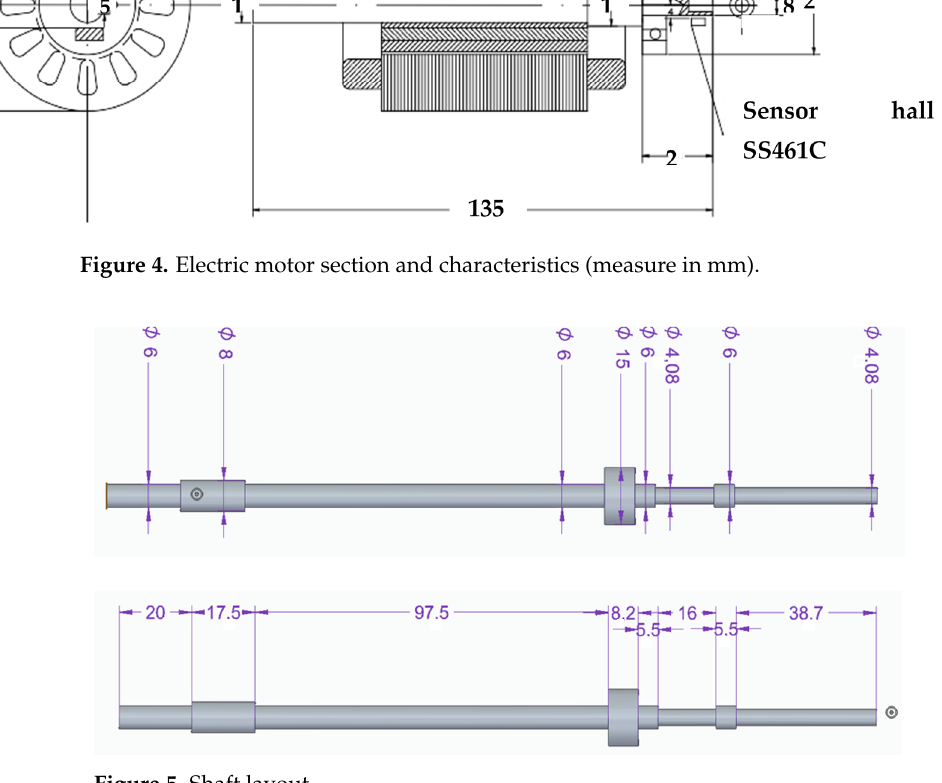
Figure 6. Discretized shaft. Figure 7. Elements that simulate the rotor of the electric motor and compressor.